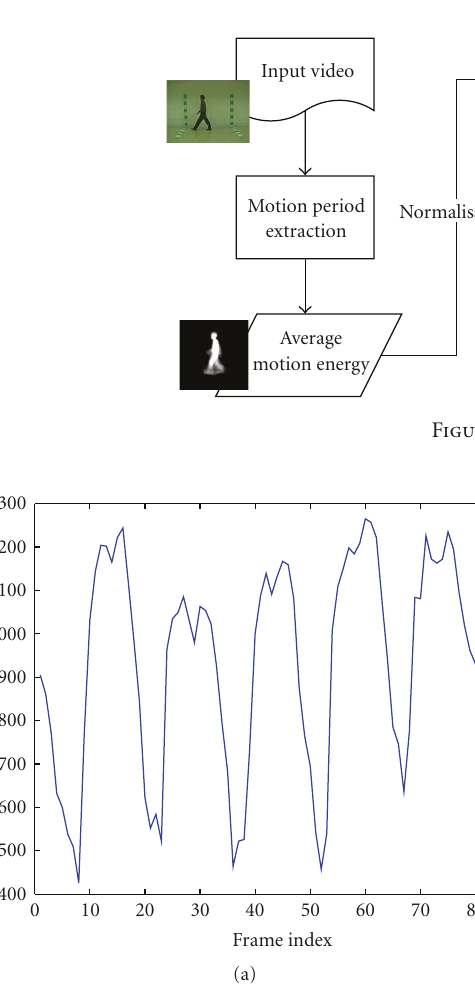
Figure 2: The size of foreground silhouette for two motions over time: (a) walking, and (b) waving one hand.